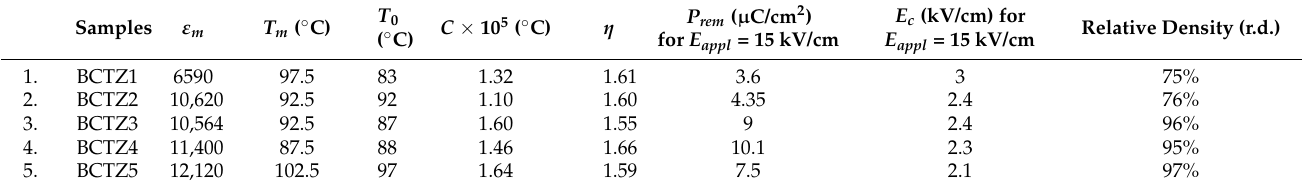
Table 1. Empirical parameters derived from the dielectric and ferroelectric data, the result of fitting with Curie–Weiss and Curie–Weiss-modified laws and relative density of BCTZ